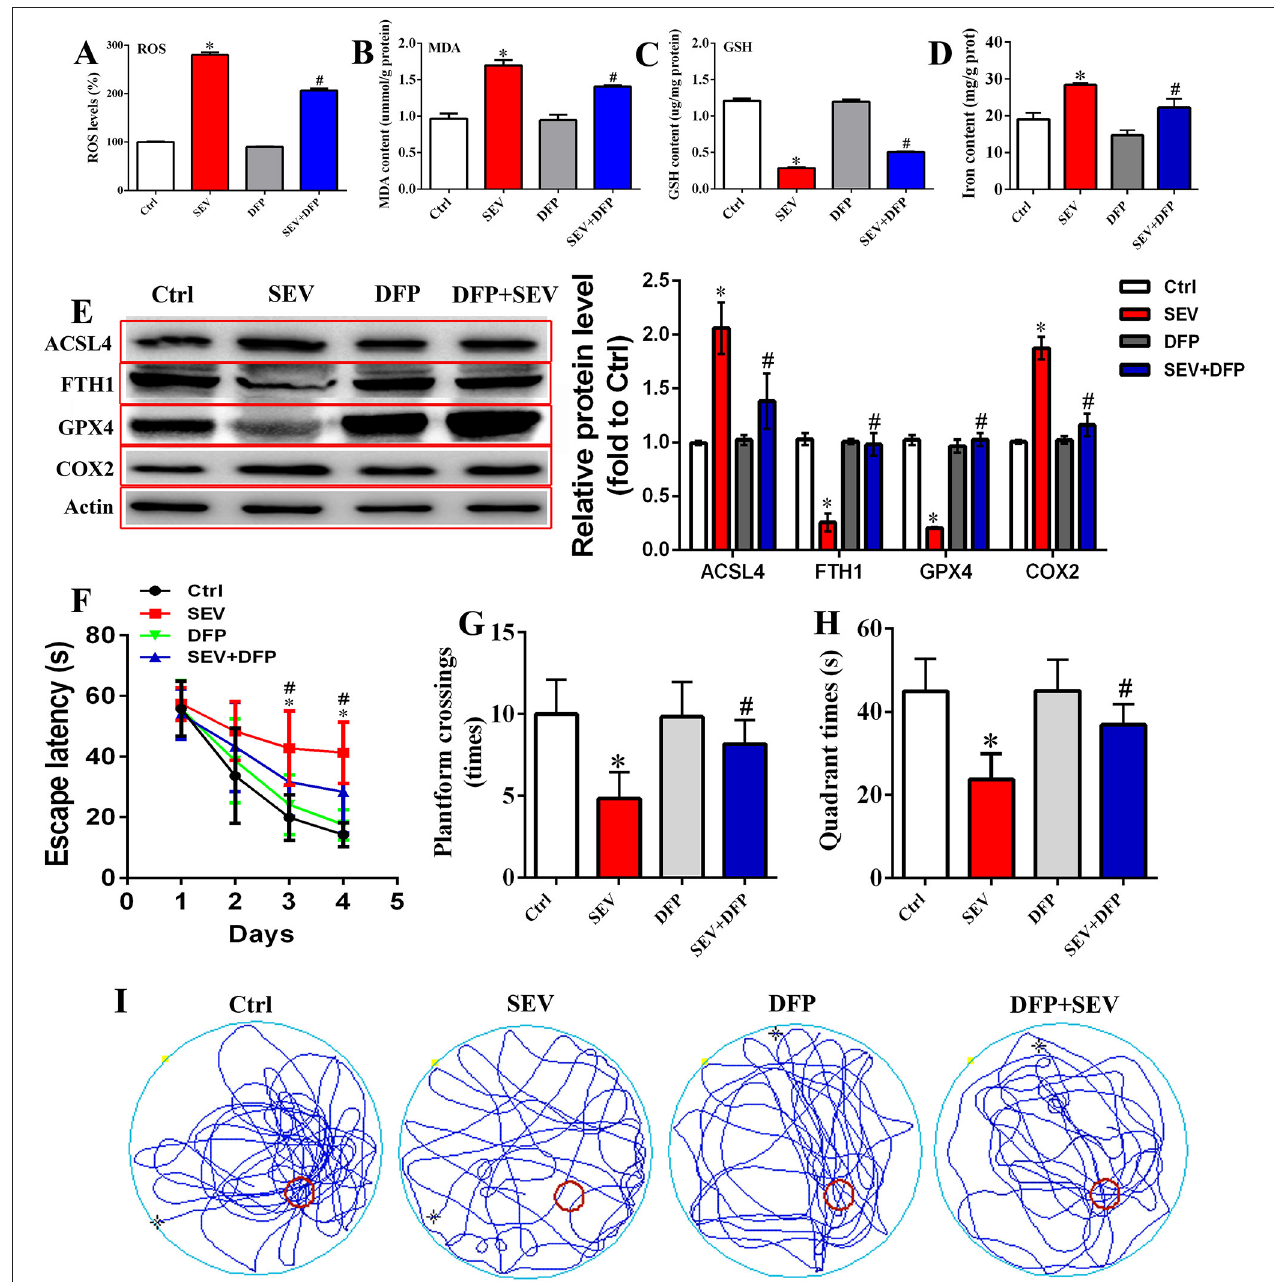
FIGURE 8 | Restriction of neurotoxic iron accumulation attenuated sevoflurane-induced cognitive dysfunction. (A) Detection for ROS level in the hippocampus [one-way ANOVA, Tukey’s multiple comparisons test, Treatment: F (3,20) = 709.2, mean difference (95% CI): − 180.0 ( − 193.5 to − 166.5) (Ctrl vs. SEV) and 73.66 (60.15 to 87.17) (SEV vs. SEV + DFP), p < 0.001]; (B–D) measurement for MDA, GSH level, and iron content [ (B) : one-way ANOVA, Tukey’s multiple comparisons test, Treatment: F (3,20) = 32.19, mean difference (95% CI): − 0.7307 ( − 0.9848 to − 0.4766) (Ctrl vs. SEV) and 0.2897 (0.03556 to 0.5438) (SEV vs. SEV + DFP), p < 0.001; (C) : one-way ANOVA, Tukey’s multiple comparisons test, Treatment: F (3,20) = 452.7, mean difference (95% CI): 0.9220 (0.8338 to 1.010) (Ctrl vs. SEV) and − 0.2172 ( − 0.3054 to − 0.1289) (SEV vs. SEV + DFP), p < 0.001; (D) : one-way ANOVA, Tukey’s multiple comparisons test, Treatment: F (3,8) = 37.00, mean difference (95% CI): − 9.387 ( − 13.69 to − 5.082) (Ctrl vs. SEV) and 6.179 (1.874 to 10.48) (SEV vs. SEV + DFP), p < 0.001]; (E) WB assay for assessing ACSL4, FTH1, GPX4, and COX2 protein expression [ACSL4: one-way ANOVA, Tukey’s multiple comparisons test, Treatment: F (3,8) = 23.58, mean difference (95% CI): − 1.067 ( − 1.530 to − 0.6037) (Ctrl vs. SEV) and 0.6793 (0.2160 to 1.143) (SEV vs. SEV + DFP), p < 0.001; FTH1: one-way ANOVA, Tukey’s multiple comparisons test, Treatment: F (3,8) = 80.13, mean difference (95% CI): 0.7734 (0.5832 to 0.9636) (Ctrl vs. SEV) and − 0.7261 ( − 0.9163 to − 0.5359) (SEV vs. SEV + DFP), p < 0.001; GPX4: one-way ANOVA, Tukey’s multiple comparisons test, Treatment: F (3,8) = 204.9, mean difference (95% CI): 0.8170 (0.6903 to 0.9437) (Ctrl vs. SEV) and − 0.8194 ( − 0.9461 to −